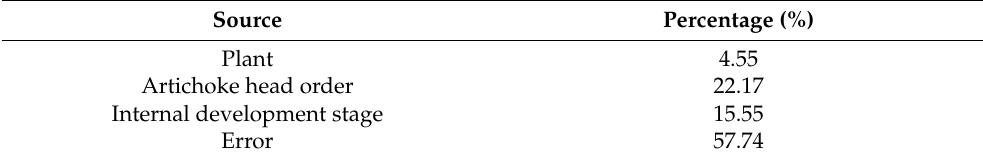
Table 2. Analysis of variance components for phenolic content for ‘Lorca’